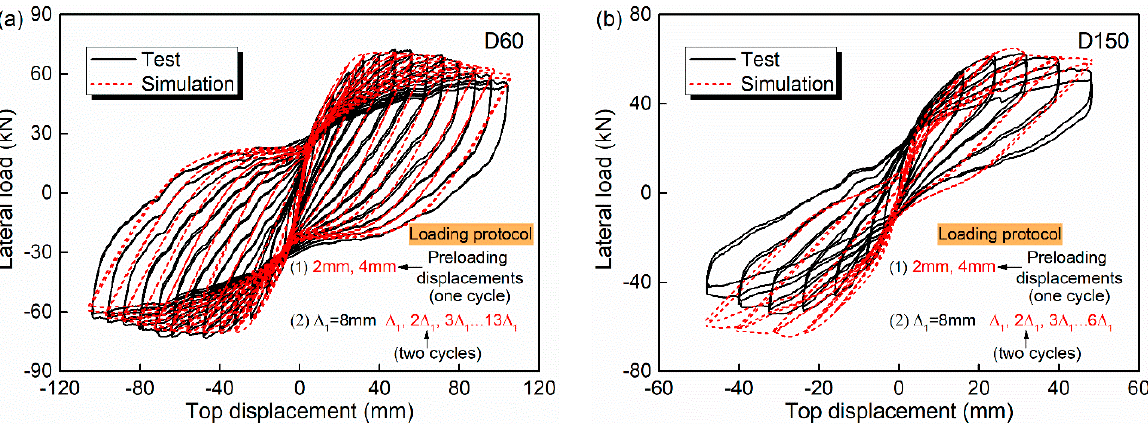
Figure 6. Simulation and test results of lateral load-top displacement: ( a ) Specimen D60; ( b ) Speci- men D150. Table 2. Comparisons between the simulation and test results.